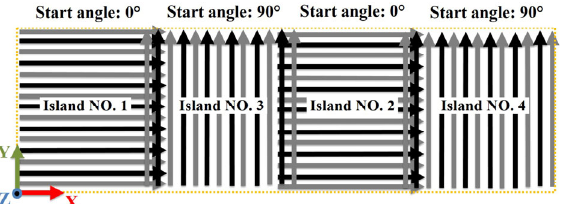
Figure 3. Schematic of the default scanning strategy with a starting angle of 0° and a rotation angle of ~72°: with ( a ) bidirectional and ( b ) unidirectional scanning.